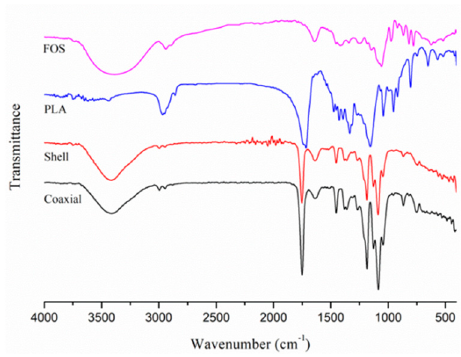
Figure 3. Fourier transform infrared (FT-IR) spectra of PLA, FOS, shell, and coaxial electrospun nanofiber films.